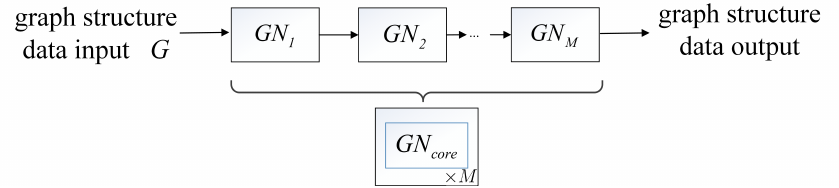
Figure 4. Composition of graph network